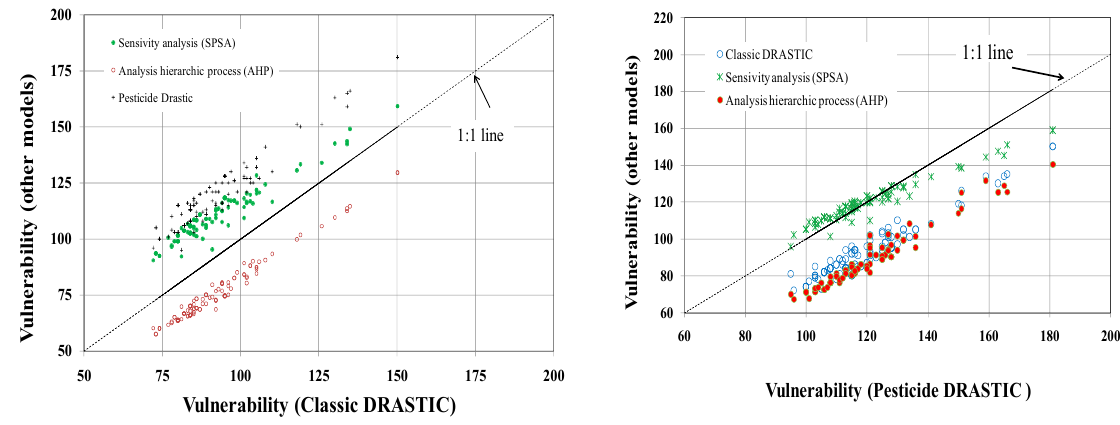
Figure 8. Comparison of vulnerability indexes (adjusted models versus the MDC and MDP models).